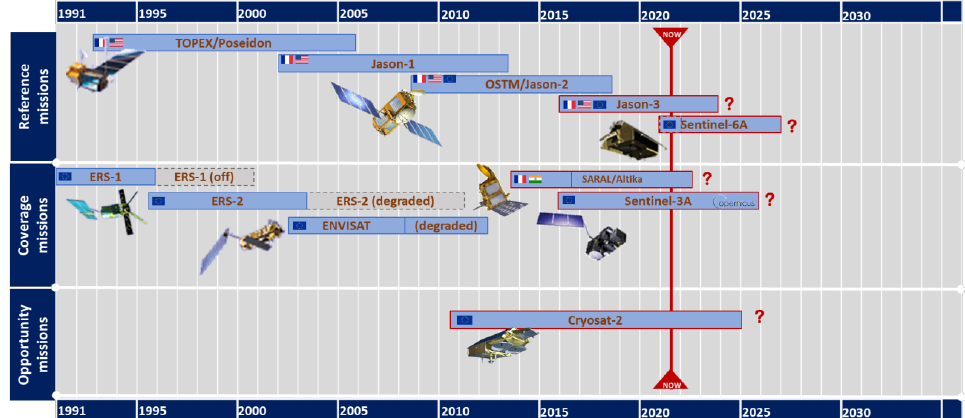
Figure 1. Complete altimetry satellite constellation used in the C3S sea level product